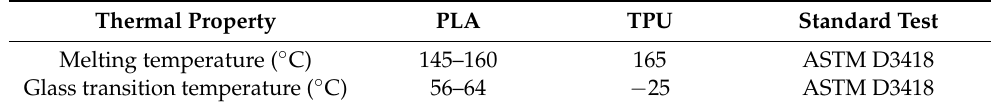
Table 1. Thermal properties of the polymers. Thermal